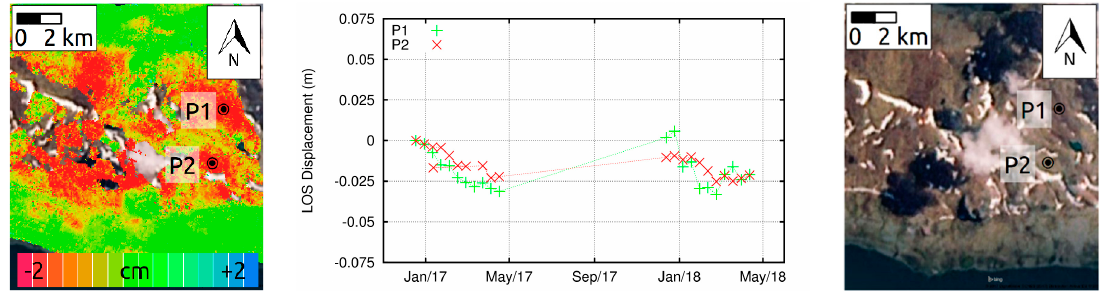
Figure 10. Subsidence map over Byers Peninsula on Livingston Island (South Shetlands Islands, Antarctica) from Sentinel ‐ 1 InSAR from 30 December 2016 to 5 April 2017. The white star indicates the reference position, the white box the enlargement of Figure 11. Remote Sens. 2018 , 10 , x FOR PEER REVIEW